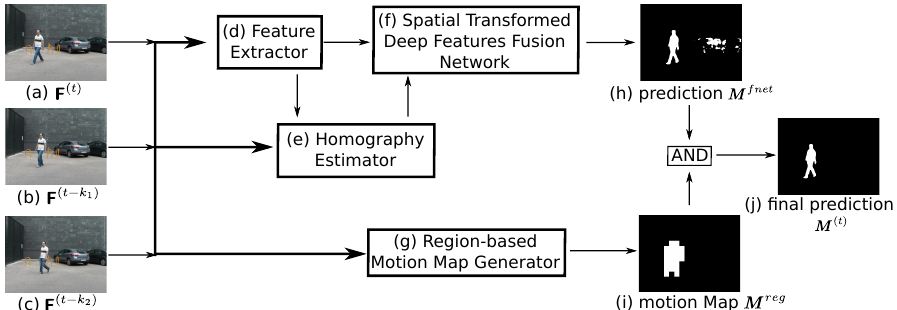
Figure 1. An illustration of the pipeline of HTFnetSeg method. Our method takes a group of frames ( a ), ( b ) and ( c ) as input, and produces a binary mask ( j ) as the output. Three major parts ( d ), ( e ), and ( f ) construct the HTFnet, which aligns and compares the frames to predict the raw foreground mask ( h ) (up). The post-process step ( g ) further boosts the final prediction to ( j ) by generating the region-based motion map ( i ) (down). The detail functions of ( d ), ( e ), and ( f ) are that: ( d ) takes the frames as input and passes the deep features to ( e ) and ( f ); ( e ) takes the frames and features as input and generates the homography matrices for ( f ); and, ( f ) uses the homography matrices to align the input deep features and finally generates the prediction ( h